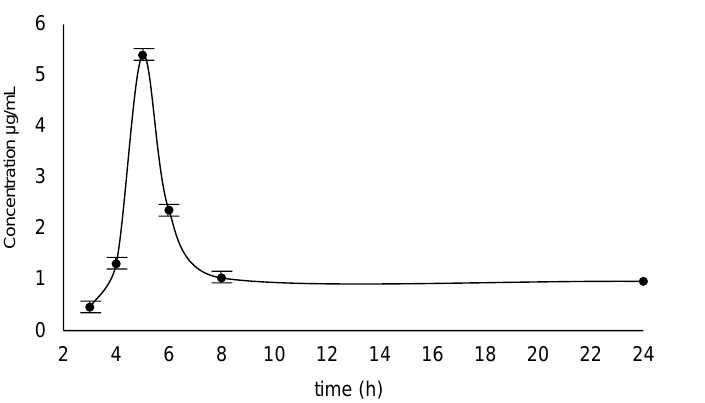
Figure 14. Concentration curve of armodafinil in human urine samples collected after 3 h, 4 h, 5 h, 6 h, 8 h and 24 h after taking 200 mg dose.